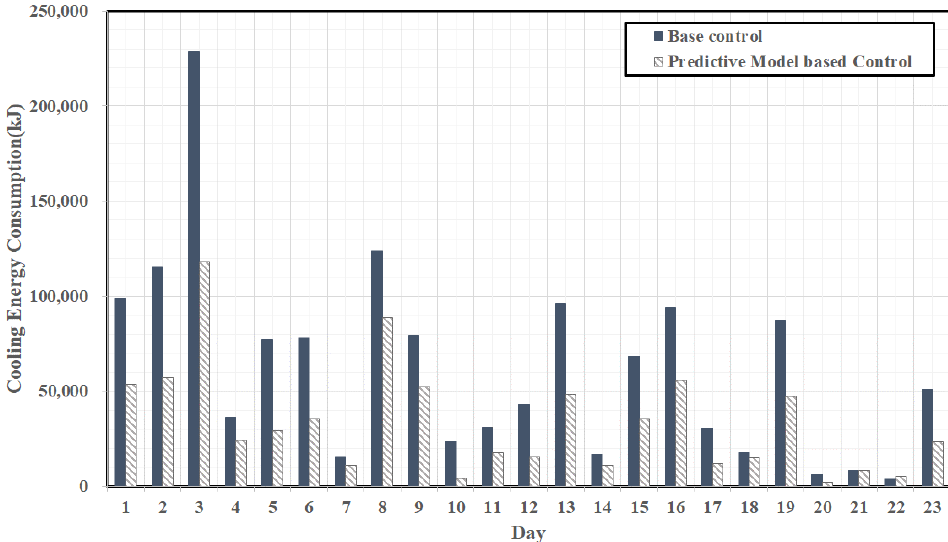
Figure 7. Comparison of cooling coil energy consumption.